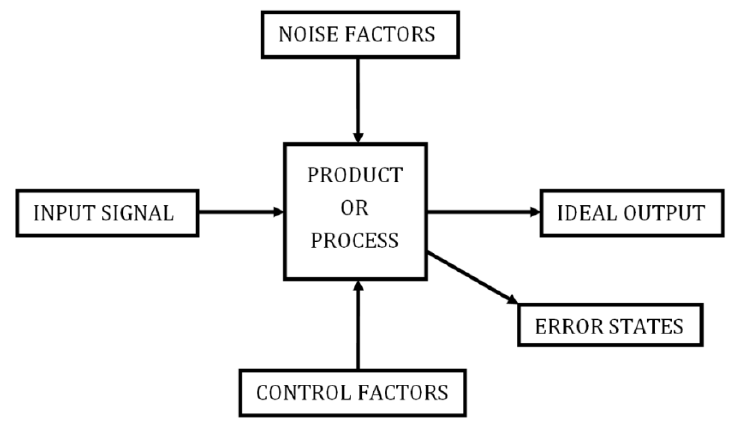
Figure 2. General layout of a P ‐ diagram.